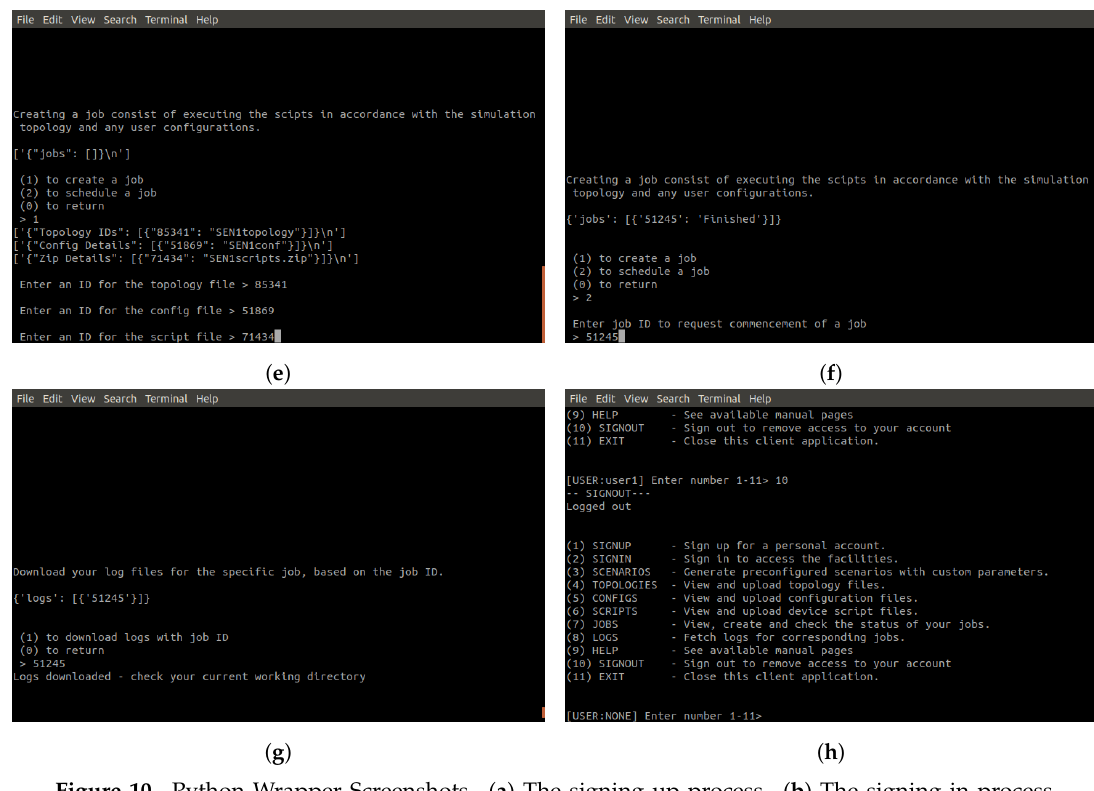
Figure 10. Python Wrapper Screenshots. ( a ) The signing up process. ( b ) The signing in process.